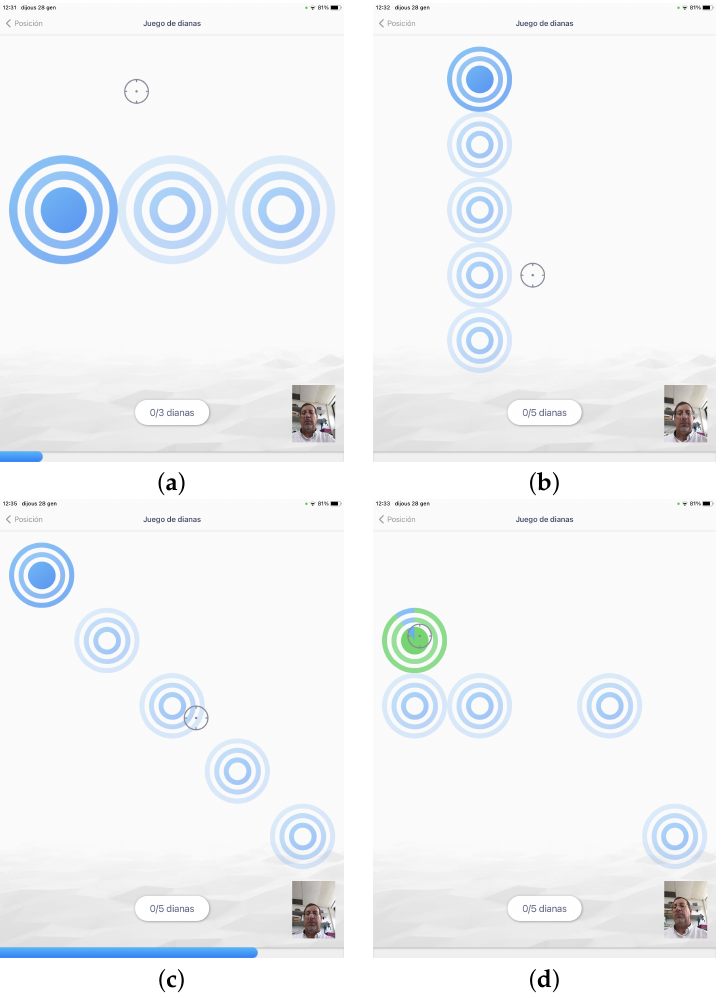
Figure 7. Examples of exercises for every preset profile: ( a ) dartboards set to induce a simple horizontal movement (rotation) with big targets, ( b ) dartboards set to induce a simple vertical descending movement (flexion) with small targets, ( c ) dartboards set in diagonal to induce a combined movement with small targets, and ( d ) dartboards set